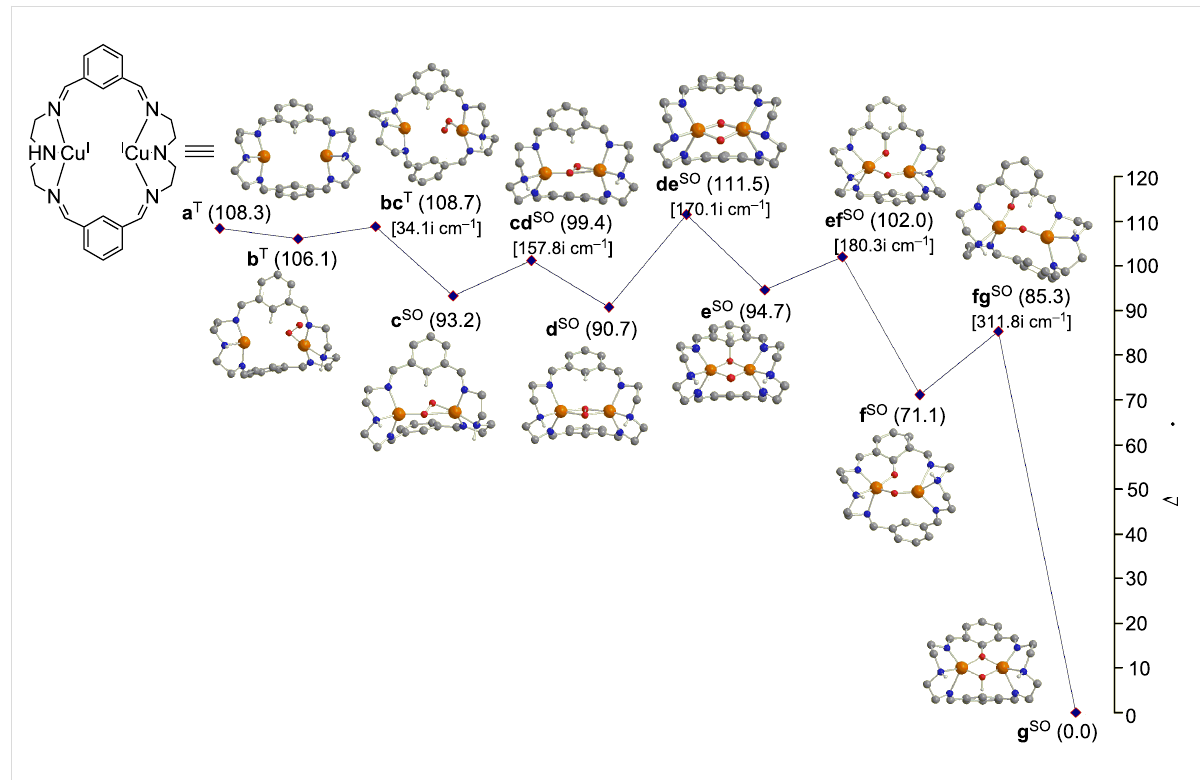
Figure 1: Stationary points located along the reaction path of the aromatic hydroxylation mechanism (some H atoms omitted for clarity). Gibbs ener- gies relative to the product (in kcal·mol − 1 ) in solution are given in parentheses. Calculated imaginary frequencies for transition structures are given in brackets. Superindexes SO (open-shell singlet) and T (triplet) refer to the multiplicity of the ground